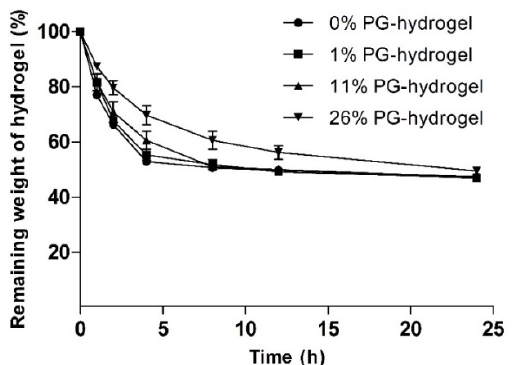
Figure 4. Effect of propylene glycol (PG) on weight loss (%). Data are expressed as the mean ± standard deviation ( n = 3).